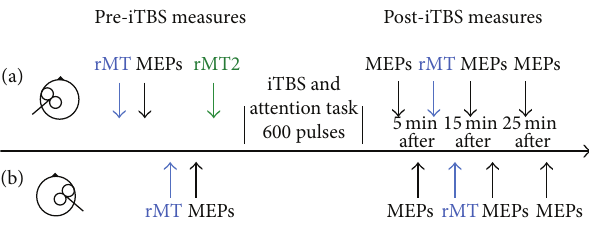
Figure 2: Experimental timeline. The timeline of measures is shown for the left (stimulated) hemisphere in the upper panel (a) and the right (unstimulated) hemisphere in the lower panel (b). Cortical excitability was probed before and after intermittent theta burst stimulation (iTBS) using resting motor threshold (rMT) and motor evoked potential (MEP) amplitude. Transcranial magnetic stimulation (TMS) targeted the representation in motor cortex of the right and left abductor pollicis brevis muscle. iTBS targeted the left(i.e.,“stimulated”)hemisphereonly.TherMT2measurewasused to establish stimulation intensity for iTBS (see Section